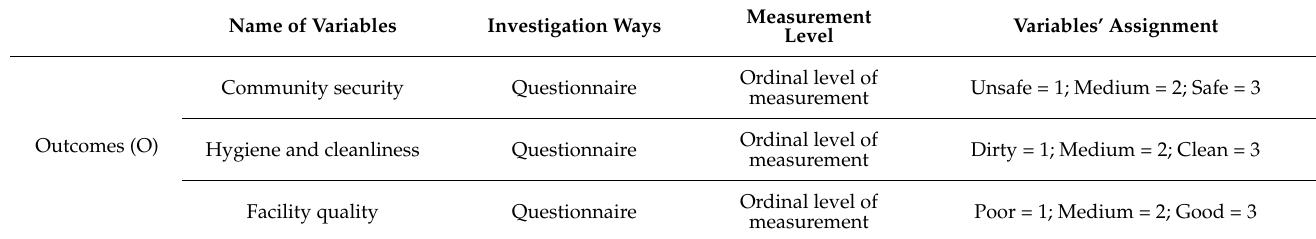
Table 2. Information of variables researched in this